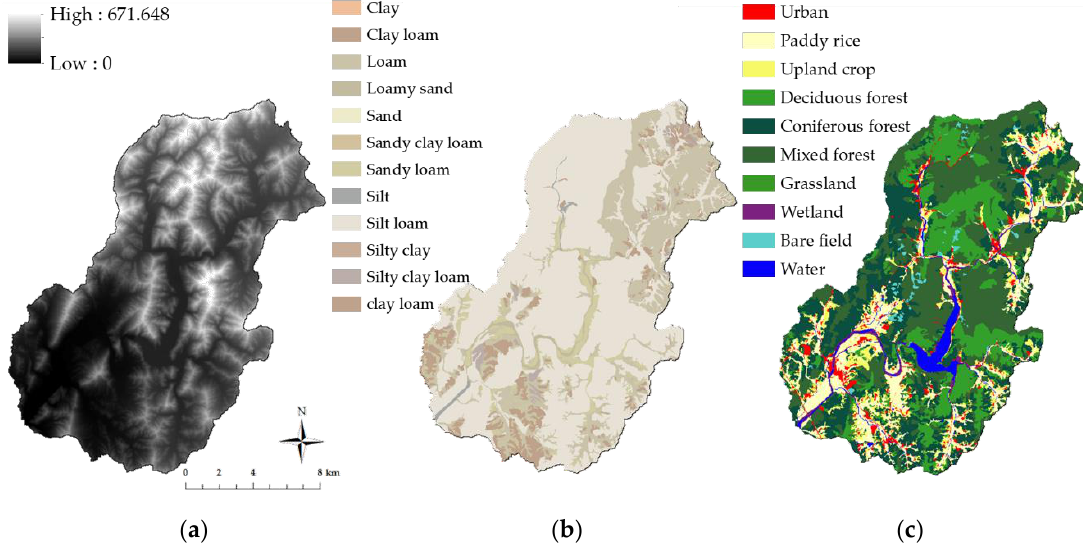
Figure 2. Study area Geographic Information System (GIS) spatial data. ( a ) Elevation; ( b ) Soil; ( c ) Land use.